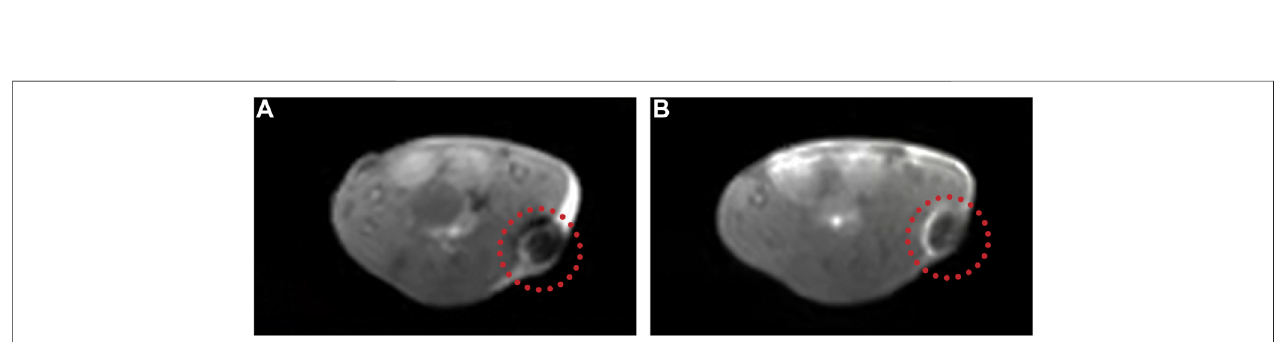
FIGURE9| The MnPBNPscanbe usedasexcellentT1contrastagents. (A) Representative T1-weighted MRIimagesofA549tumor-bearingmice beforeand (B) after intratumoral injection of MnPB NPs.